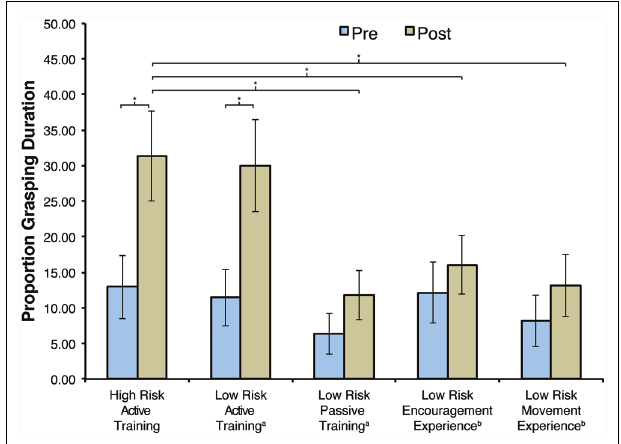
FIGURE 5 |Average face preference scores after training (Post) by group. Data from the LR groups was taken from (a) Libertus and Needham (2011) or (b) Libertus and Needham (2014). Error bars represent SEM, * p < 0.05, † p = 0.086.